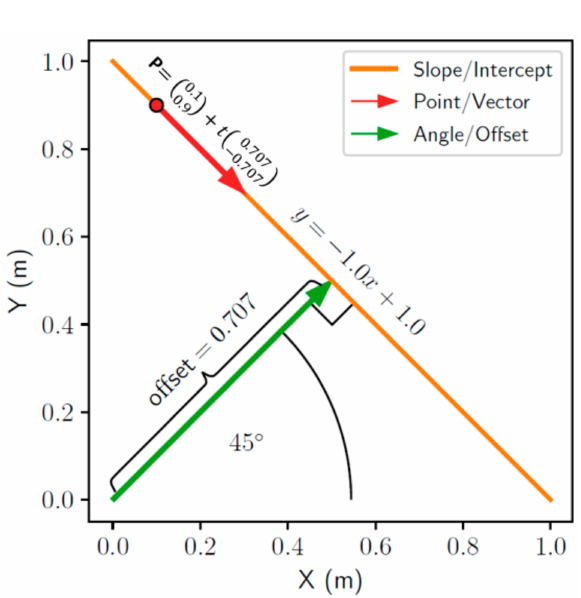
Figure 4. Visualization of three models of the same geometric